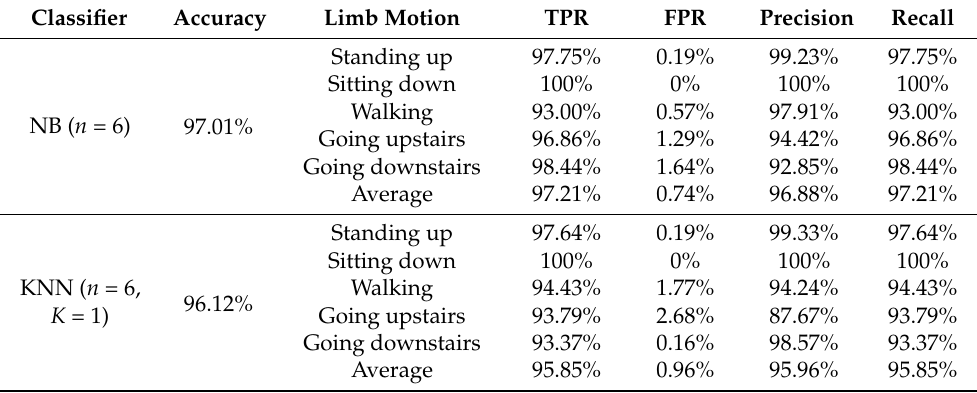
Table 2. Human limb motion recognition results of three